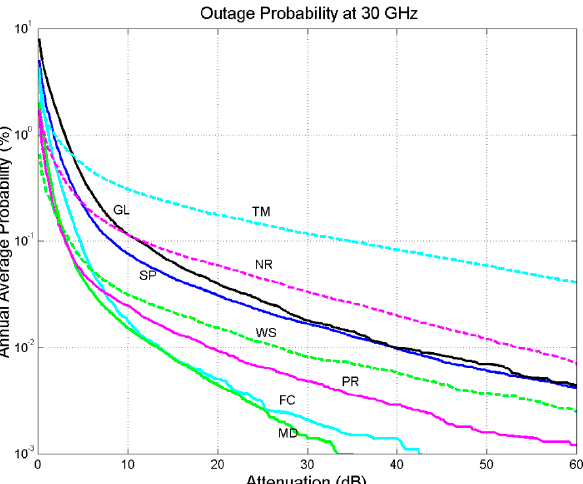
Figure 1. Annual average probability (cid:1842)((cid:1827)) (%) of exceeding the rain attenuation (cid:1827) (dB) indicated in abscissa, at the indicated sites: Spino d’Adda (SP, blue continuous line); Gera Lario (GL, black line); Fucino (FC, cyan continuous line); Madrid (MD, green continuous line); Prague (PR, magenta continuous line); Tampa (TM, cyan dashed line); Norman (NR, magenta dashed line); White Sands (WS, green dashed line), at 16 GHz in zenith paths. When the power margin in the zenith radio-links of the GeoSurf satellite constellations is equal to A (dB), P ( A ) represents the outage probability.